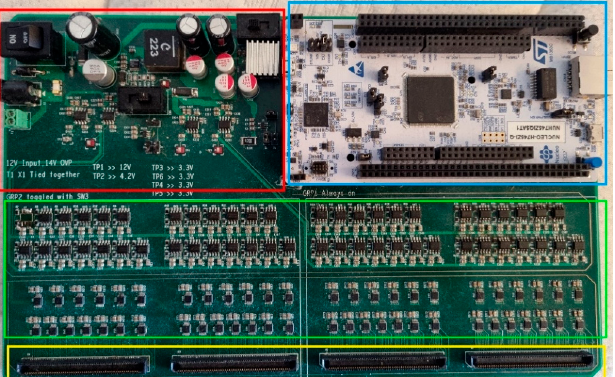
Figure 3. Motherboard. The Power Supply section (red) provides power for the whole board. The MCU section (blue) contains an STM32F7 Nucleo development board, which is used for data pro- cessing and communication with the host PC. The Sensor section (green) contains FDC1004 capaci- tance-to-digital converters and STM32G03 MCUs, which are used to collect capacitance data from the Sensor Board and transfer it to the STM32F7. The female board connectors (yellow) are used to connect the Sensor Board to the Motherboard.